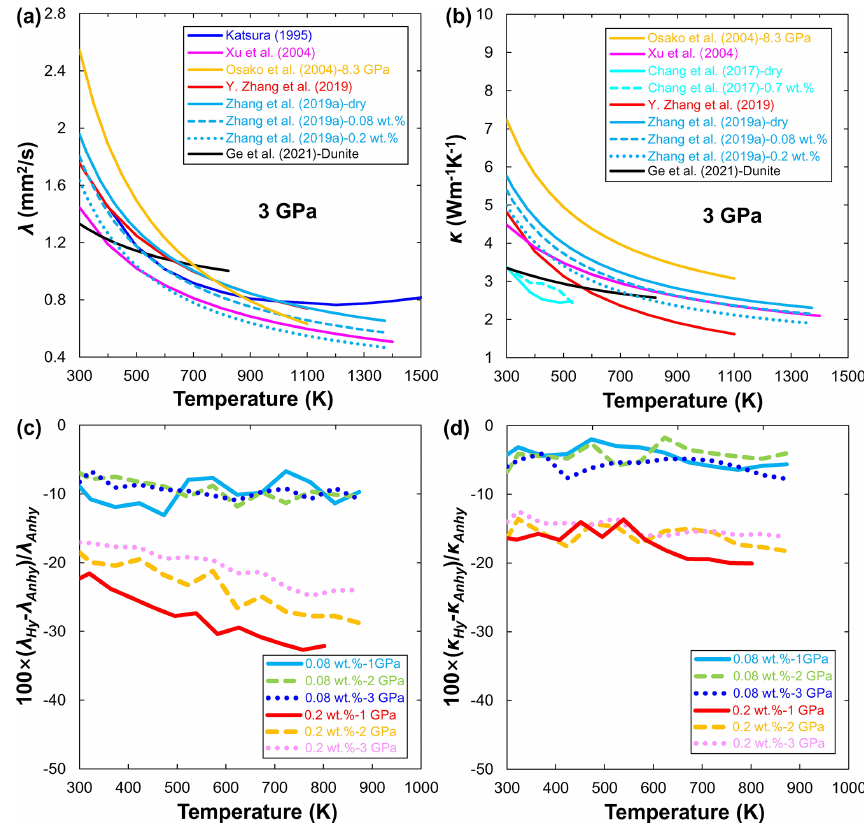
Figure 8. Temperature dependence of thermal diffusivity (a) and thermal conductivity (b) for dry (Katsura, 1995; Xu et al., 2004; Osako et al., 2004; Y. Zhang et al., 2019; Ge et al., 2021) and hydrous olivine (Chang et al., 2017; B. H. Zhang et al., 2019a) at 3GPa. Reduction (%) of the thermal diffusivity (c) and thermal conductivity (d) of hydrous olivine to its anhydrous counterpart as a function of temperature and pressure reported by B. H. Zhang et al.